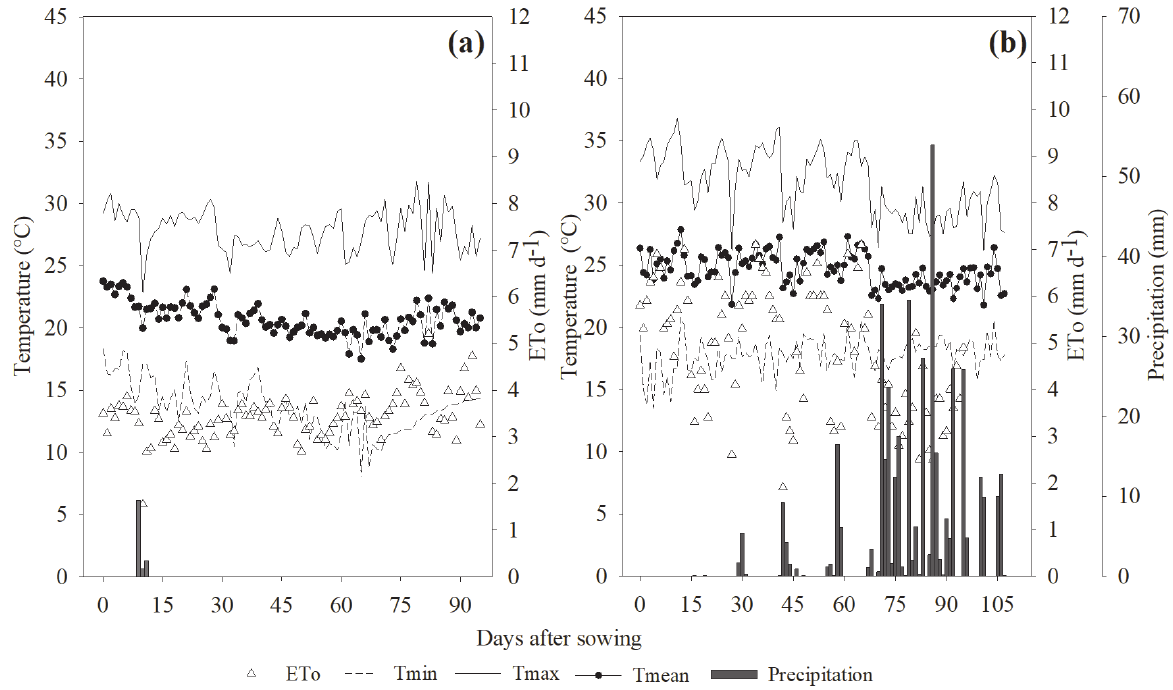
Figure 1. Maximum (Tmax), mean (Tmean) and minimum (Tmin) air temperatures, reference evapotranspiration (ETo) and precipitation observed in the winter (a) and summer (b)